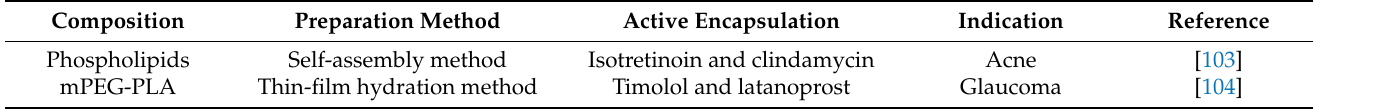
Table 6. Examples of polymeric micelles and the diseases that can benefit from co-encapsulated